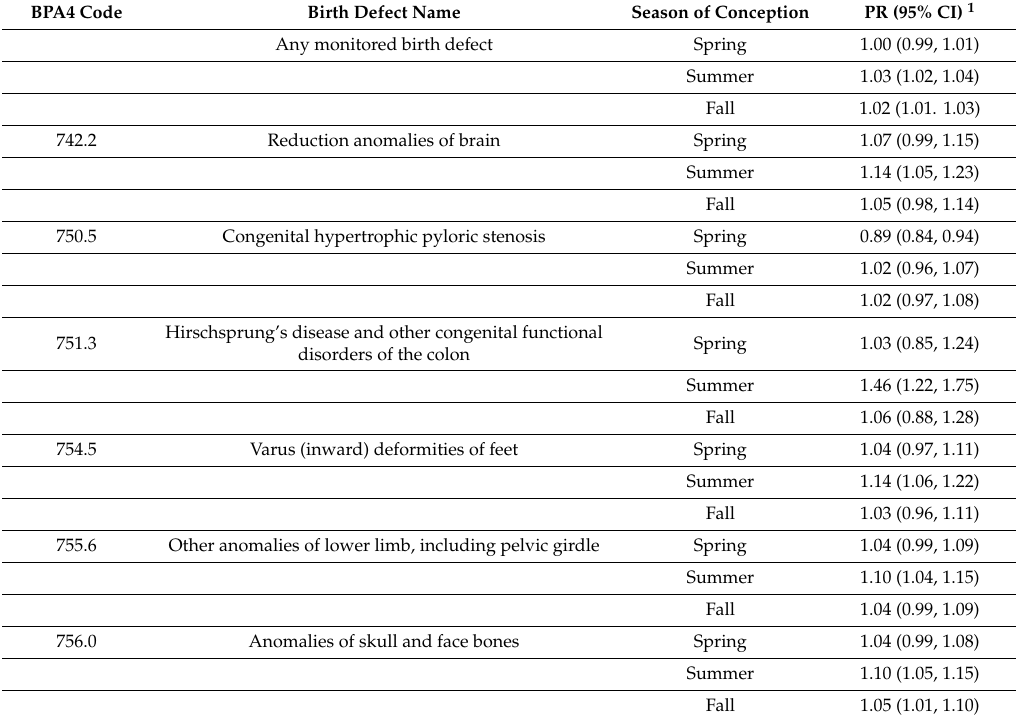
Table 2. Adjusted prevalence ratios and 95% confidence intervals for the associations between replicated birth defects and season of conception, estimated among all study